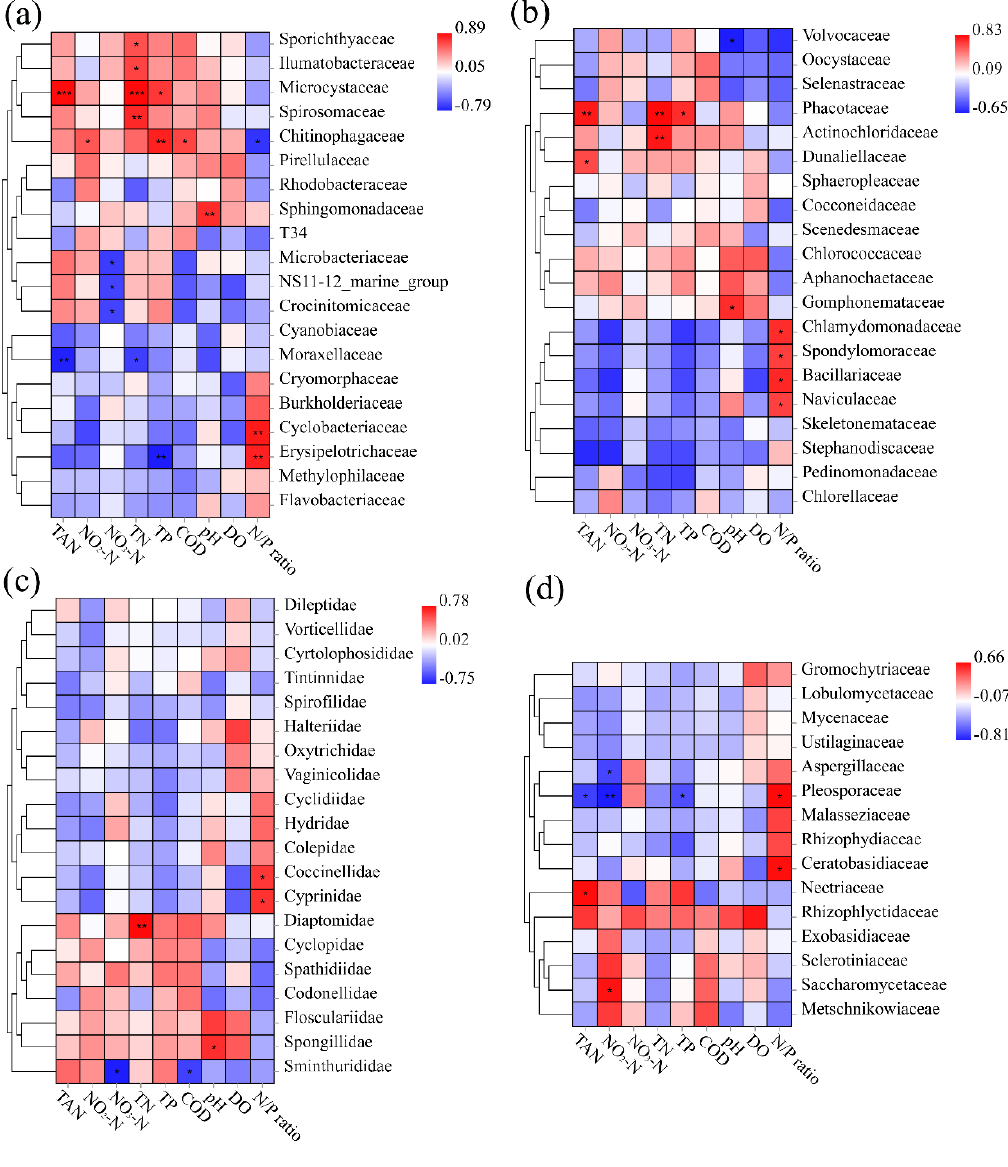
Figure 6. Correlation between environmental factors and families ’ abundance of ( a ) bacteria, ( b ) phytoplankton, ( c ) zooplankton and ( d ) fungi. * represents p value < 0.05, ** represents p value < 0.01, and *** represents p value < 0.001.